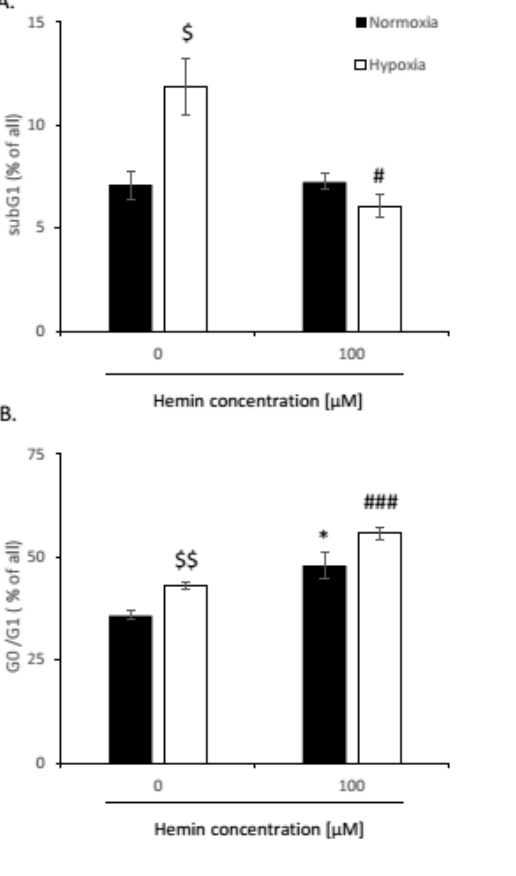
Figure A13. Cont